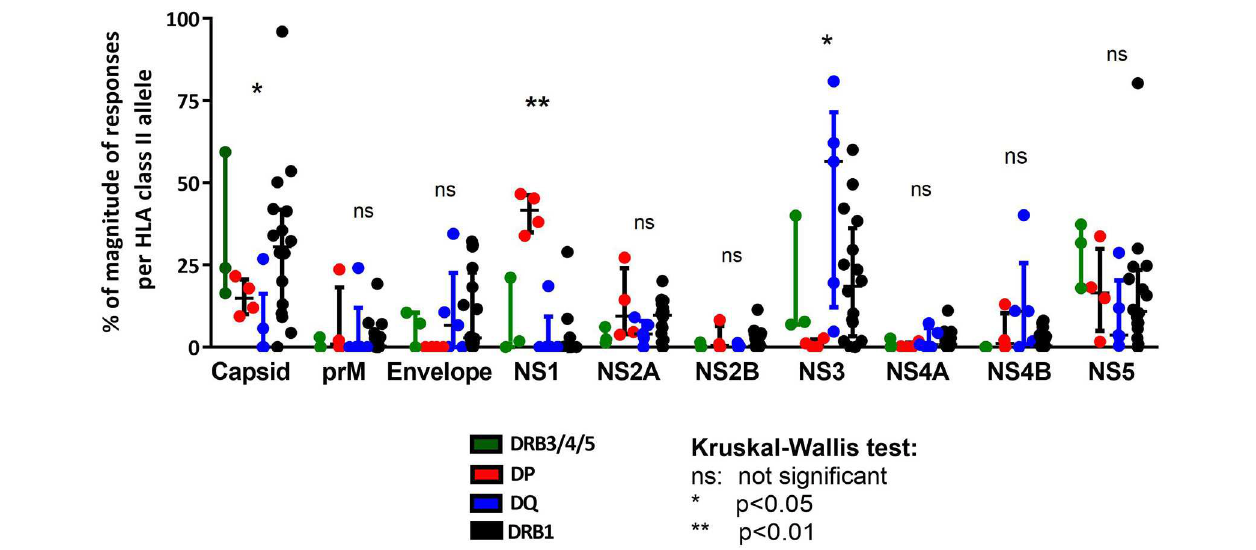
FIGURE 3 | Immunodominance protein pattern of HLA class II loci comparison. Protein immunodominance observed in the previously published HLA-DRB1 locus as reference (black) (15) is compared with HLA-DP (red), HLA-DQ (blue), and HLA-DRB3/4/5 loci (green). Each dot represents the percentage of magnitude of responses per allele in the respective locus divided for DENV protein composition. Statistical analysis per protein have been performed using one-way ANOVA non-parametric Kruskal-Wallis test.